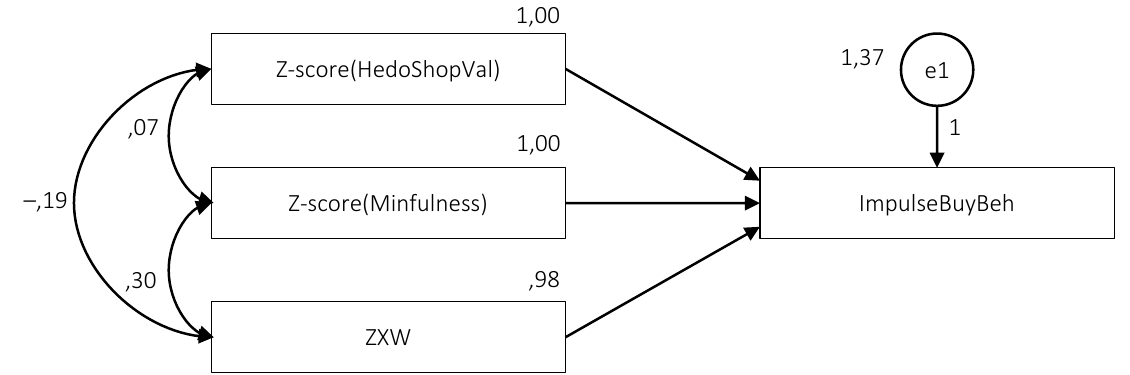
Figure 3. The standardized path diagram of the moderator effect of hedonic shopping value on the relationship between mindfulness and impulse buying behavior Table 9. Hedonic shopping motivation slope test